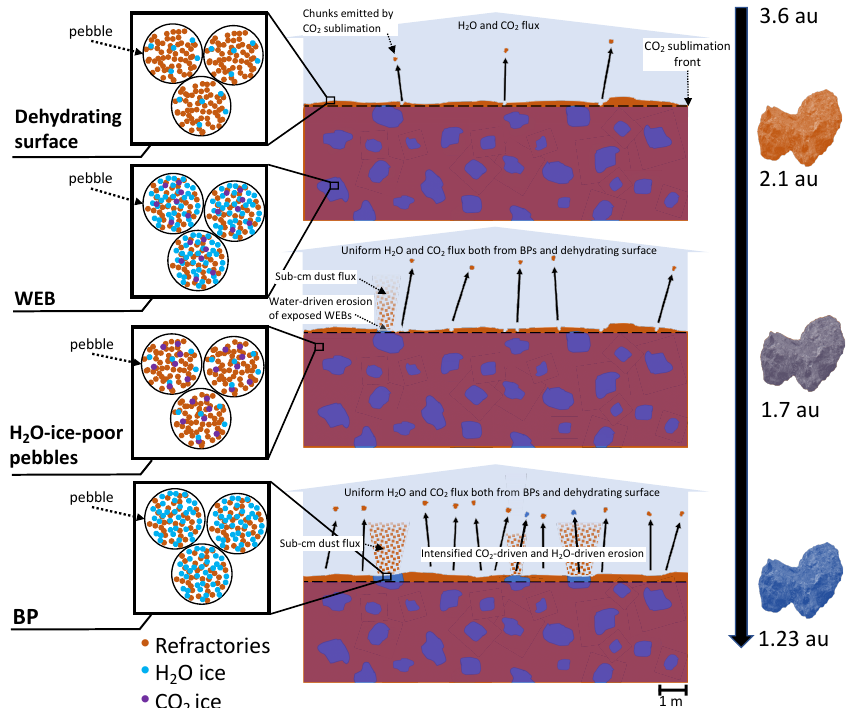
Figure 1. Pictogram showing the macro-structure of a comet nucleus, reprinted by permission from Nature/Springer/Palgrave, Nature Astronomy, Macro and micro structures of pebble-made cometary nuclei reconciled by seasonal evolution, Ciarniello, M. et al. Natur Astr., 6, 546–553 (2022). The evolution of the surface and subsurface is sketched here as a function of heliocentric distance (displayed on the right). The nucleus is composed of two types of pebbles made of refractories and ices: water-rich pebbles depleted of supervolatiles (forming the WEBs) and water-poor ones rich in supervolatiles (the red matrix). CO 2 ice survives under its condensation front at depths >0.1 m. Its sublimation rate increases approaching perihelion, eroding the surface by chunk ejection and exposing the subsurface WEBs. Water-ice sublimation erodes the exposed WEBs while removing sub-cm dust from their surface and preventing the formation of a dry crust. Dehydration overcomes erosion in the water-poor pebbles, but the formation of a crust is prevented by the ongoing CO 2 erosion. Exposed WEBs and dehydrating surface eject the same water flux, because both have some water-ice inside and are assumed to be at the same temperature. The structure of the inhomogeneous water-poor and water-rich pebbles composed of sub-cm dust and ice particles is not shown